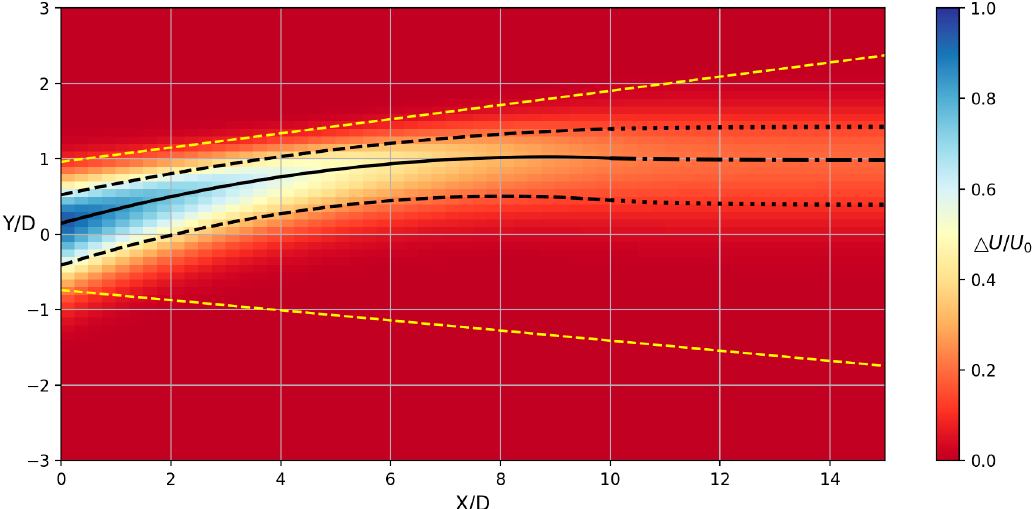
Figure 3. The velocity contour of Case 1 (Single rotor). The color bar is the velocity deficit, the black solid line represents the position of the maximum velocity deficit, and the two black dashed lines represent the deviations of the two sides. The yellow dashed lines represent the wake edges model [15] under the same experimental condition.